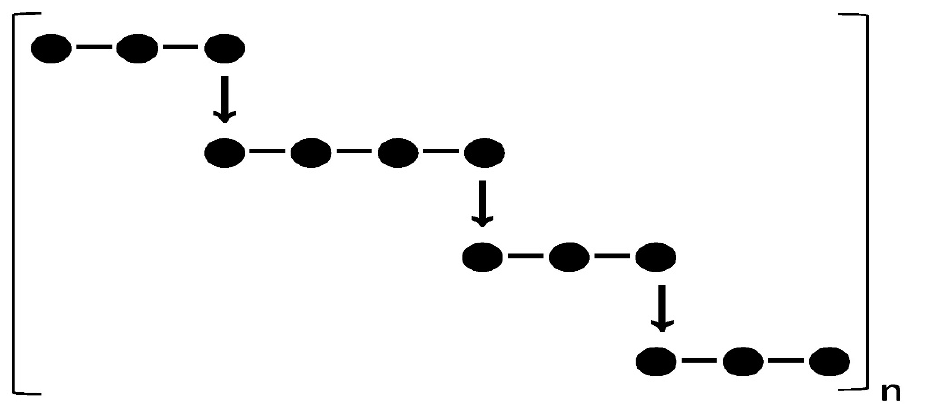
Figure 1. The structure of pullulan consists of maltotriose and maltotetraose units (glucose residue = ) connected through α -D-(1 → 6) bonds on its terminal glucose residues.